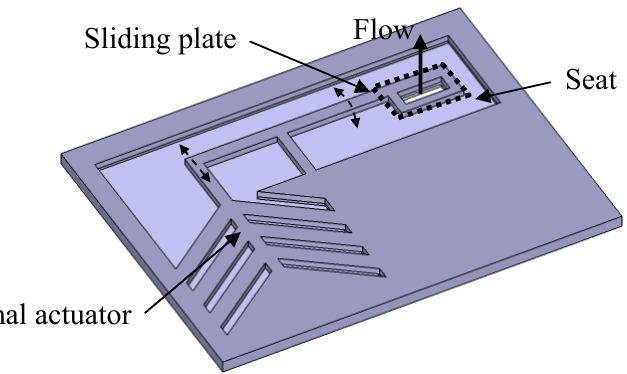
Figure 8. Horizontally translating plate microvalve using thermal actuation in a pivoting design [28]. The dashed line marks the perforated plate, which overlaps with the inlet and outlet